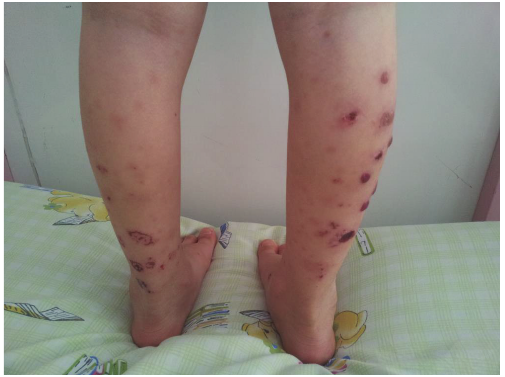
Figure 2: Neutrophilic inflammation with fibrinoid necrosis and fragmented neutrophilic nuclei (leukocytoclasis). HEX 300.